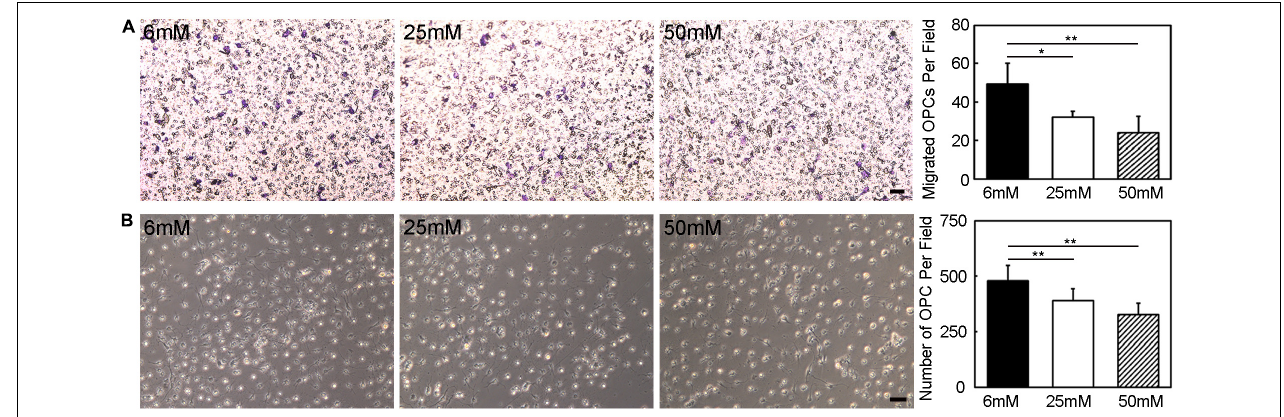
FIGURE 7 | Hyperglycemia eliminated the OPC migration and survival ability. (A) The migration ability of OPCs was assessed by transwell in vitro . Images showed the migrated OPCs in the 6 mM, 25 mM, and 50 mM glucose in 18 h cultured condition. Scale bar = 50 µ m. (B) Images and bar graph showed the number of survived OPCs in the 6 mM, 25 mM and 50 mM glucose in 3-day cultured condition. Scale bar = 50 µ m. Data are mean ± SD , n = 6 per group, * p < 0.05, ** p < 0.01, 25 mM or 50 mM vs. 6